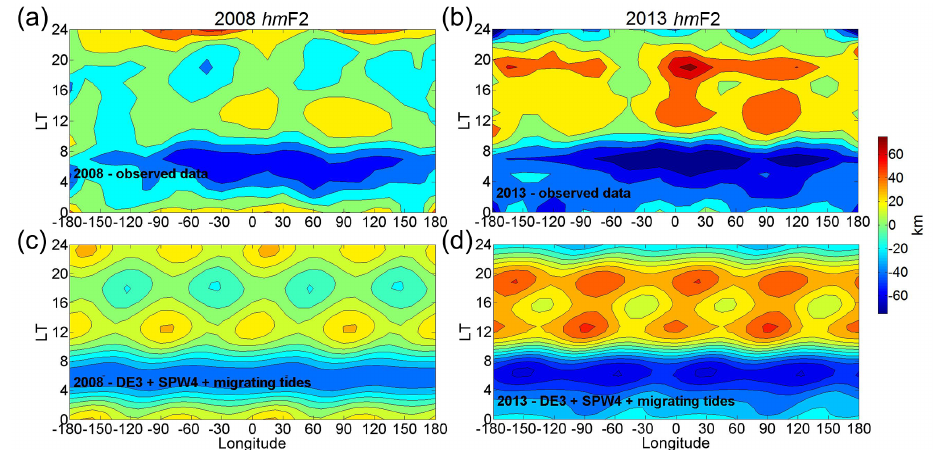
Figure 10. Observed and reconstructed hm F2 for 2008 and 2013 around September equinoxes. Panels (a, c) are related to 2008, while (b, d) are related to 2013. Panels (a, b) are the observed hm F2 variation contour plots, also present in Fig. 4. Panels (c, d) were reconstructed using SPW4, DE3 and migrating tide waves’ (DW1, SW2 and TW3) signatures observed in the spectral analysis (not shown) at ionospheric altitudes. Both reconstructions in bottom figures clearly show a wave-4